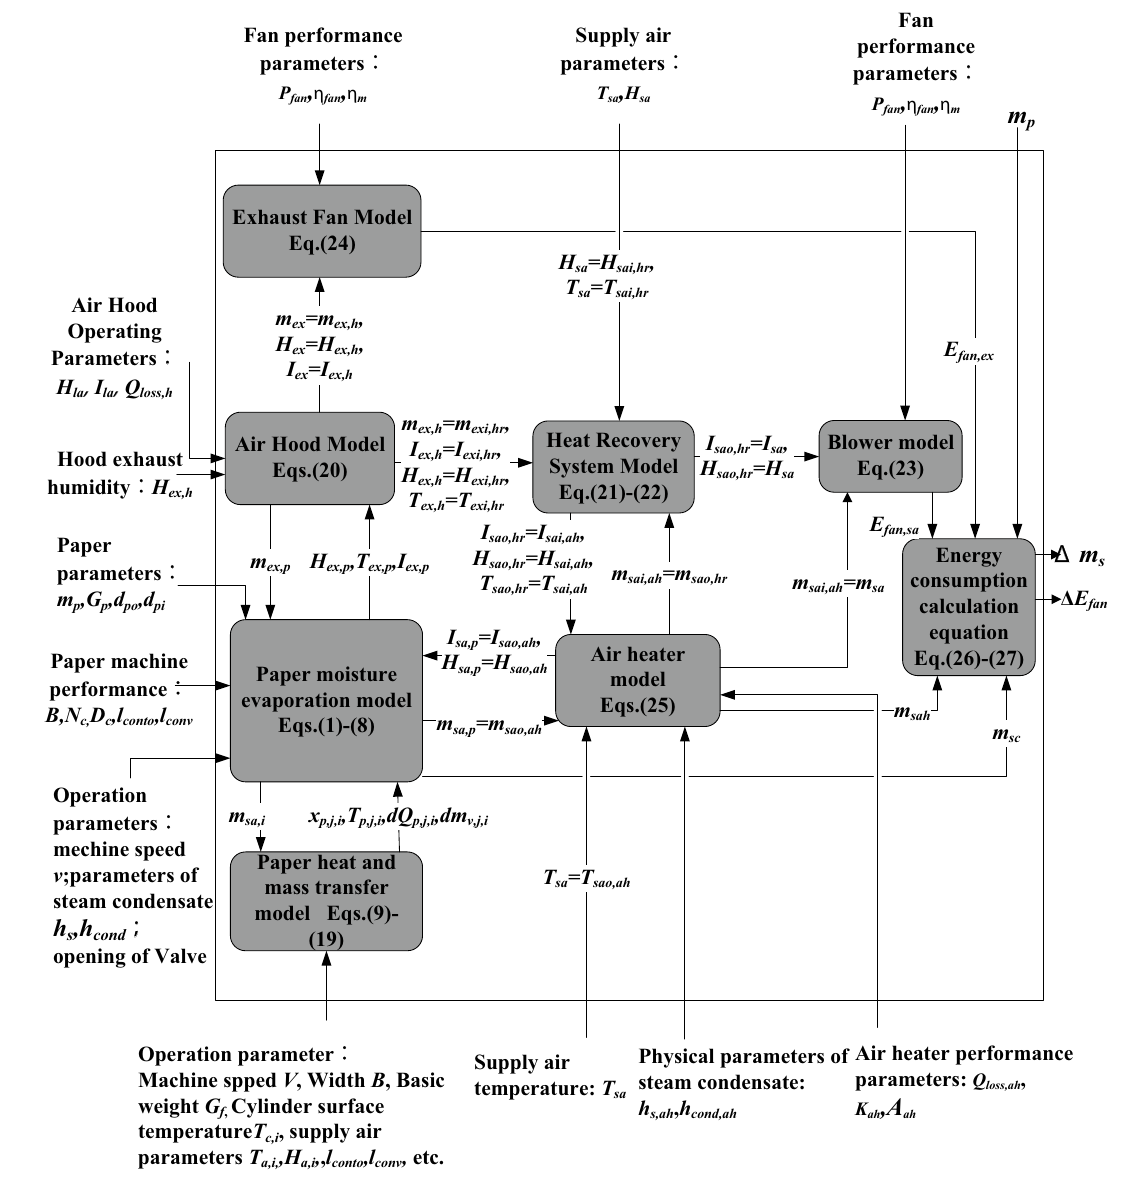
Fig. 7 Energy consumption model of drying